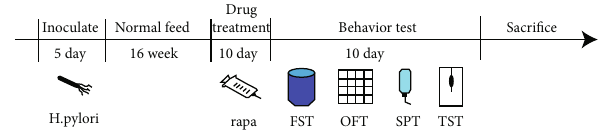
Figure 1: Flow diagram of the